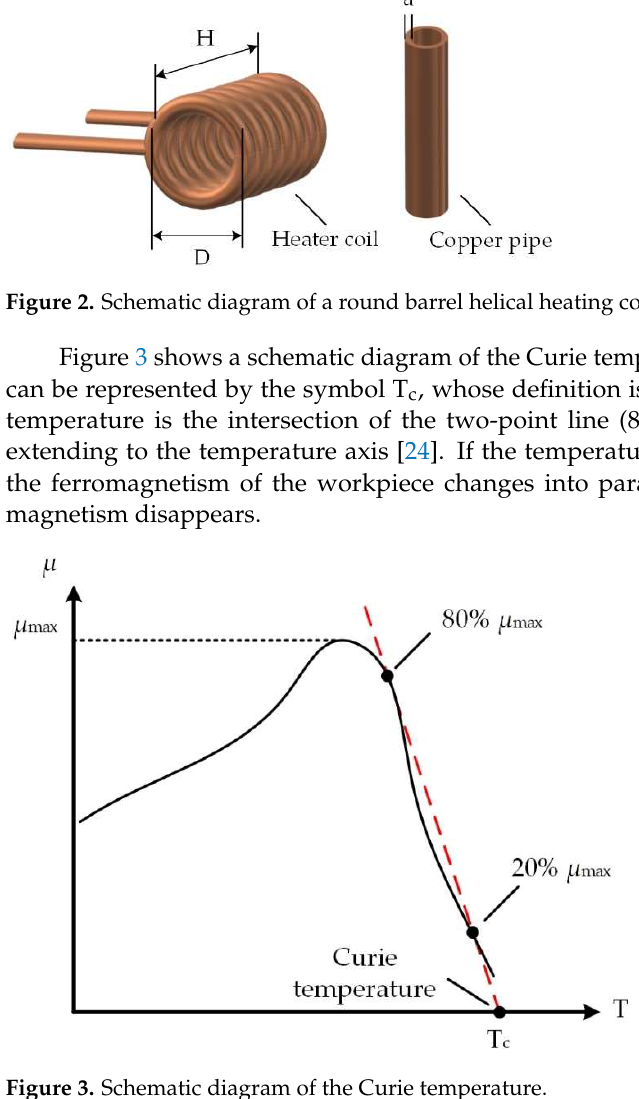
Figure 3. Schematic diagram of the Curie temperature.